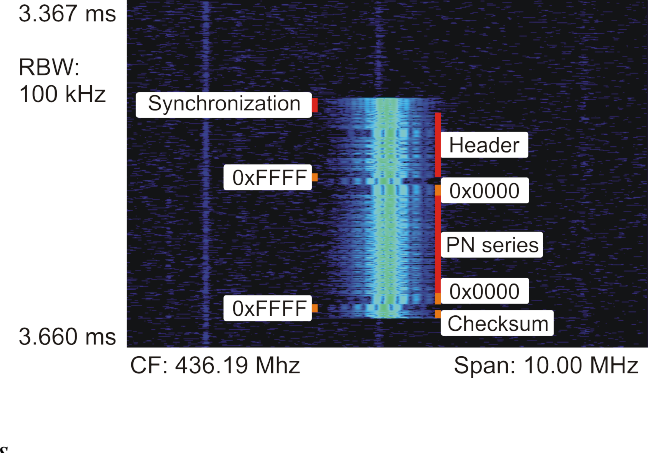
Figure 9. Measured spectrogram of the transmission of one packet. First, the sync word was sent to signalize the transmission of a new packet to the receiver and to ensure that the channel was clear. This was done by switching between 0 and 1. Then, the protocol header was sent, including information such as packet size and recipient address. The actual payload was marked with four flag bytes (0 × 0000 0 × FFFF, and vice versa) before and after, with a visible spectrum shift. The transmission was concluded with the